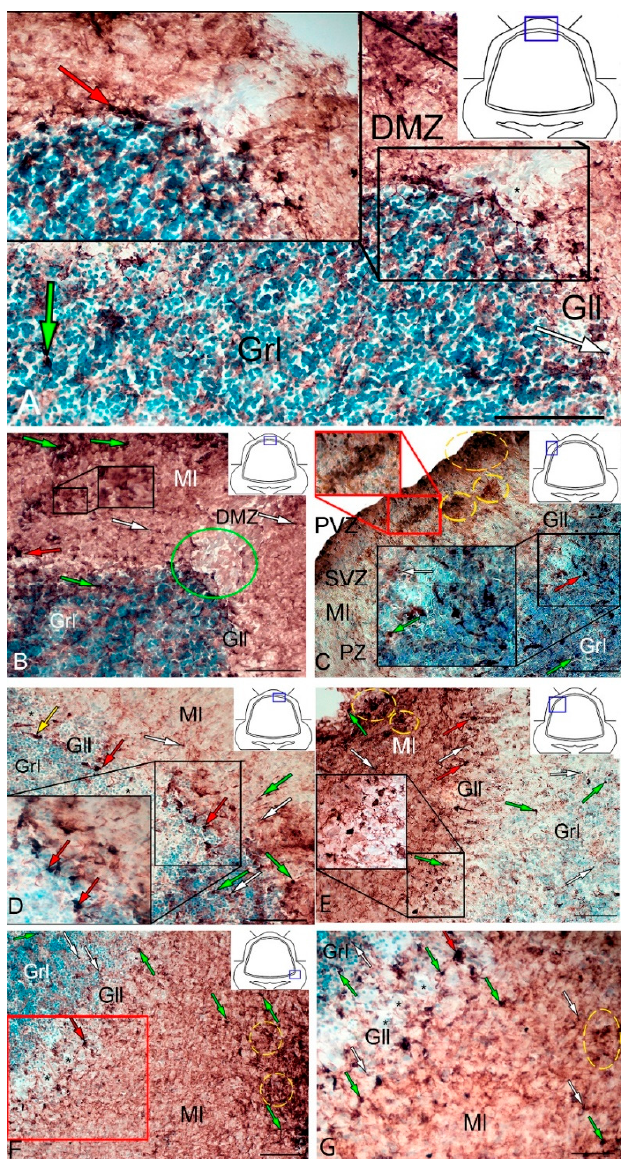
Figure 5. Distribution of glutamine synthetase (GS) in the intact cerebellum of juvenile masu salmon Oncorhynchus masou . ( A ) General view of the dorsal zone (DZ) in the rostral part of the cerebellum: GS+ type 1 cells (white arrows); GS+ type 2 cells (green arrows) and GS+ type 3 cells (red arrows); dorsal matrix zone (DMZ) (black inset); ganglionic layer (Gll); granular layer (Grl). ( B ) General view of the DZ of the caudal part of the cerebellum: aggregation of GS+ cells (black inset); DMZ (green oval); molecular layer (Ml), and other designation see in Figure 5A. ( C ) Cluster of type 3 cells in the ganglionic layer of the DZ (indicated by red arrows in the inset). ( D ) Lateral zone (LZ) in the rostral part of the cerebellum: aggregation of GS+ cells in the periventricular zone (PVZ) of the molecular layer (yellow dotted oval); aggregation of GS+ cells in the parenchymal part of the molecular layer (red inset); aggregation of GS+ cells in the granular layer (black inset); GS+ type 1 cells (white arrows); GS+ type 2 cells (green arrows); GS+ type 3 cells (red arrows); the yellow arrow indicates an eurydendroid cell; subventricular zone (SVZ), parenchymal zone (PZ). ( E ) LZ caudal cerebellum: GS+ cells of type 3 in the ganglionic layer (black inset); see designations in Figure 5C. ( F ) Basal zone (BZ): clusters of GS+ cells of the molecular layer (yellow dashed oval); GS − cells are indicated by asterisks. ( G ) Enlarged fragment of BZ in red inset on F. IHC labeling with GS. The blue rectangle in the pictogram indicates the corresponding area in the micrograph. Scale bars: ( A – F ) 100 μ m; ( G ) 50 μ m.